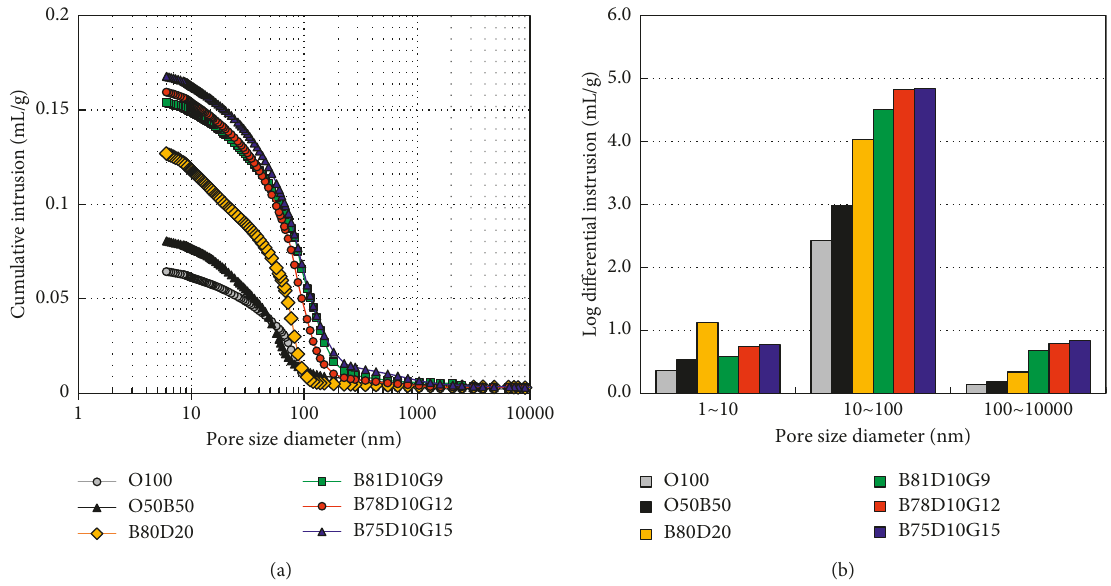
Figure 8: Porosity of samples by binder types. (a) Cumulative pore volume. (b) Distribution of pore